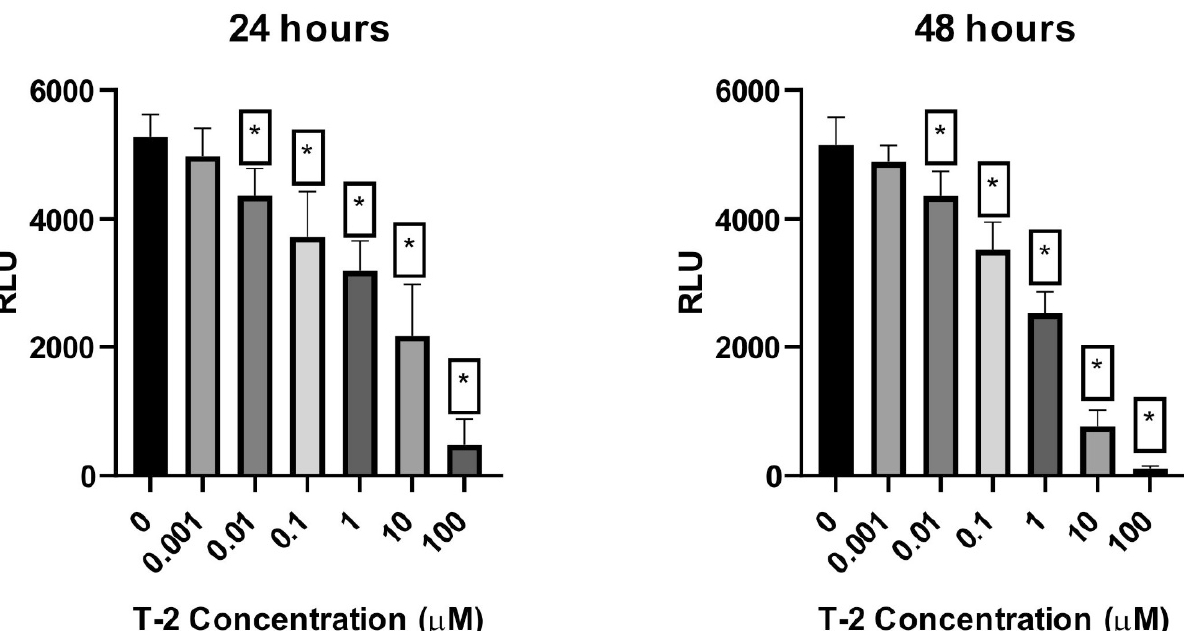
Figure 3. The T-2 toxin effect on the necrosis of ATP-level Hs68 cells estimated by the bioluminometry method. Values: means ± SD ( n = 6). * p < 0.001. 0: untreated (control) cells; 0.001: concentration of toxin—0.001 µ M; 0.01: concentration of toxin—0.01 µ M; 0.1: concentration of toxin—0.1 µ M; 1: concentration of toxin—1 µ M; 10: concentration of toxin—10 µ M; 100: concentration of toxin—100 µ M.